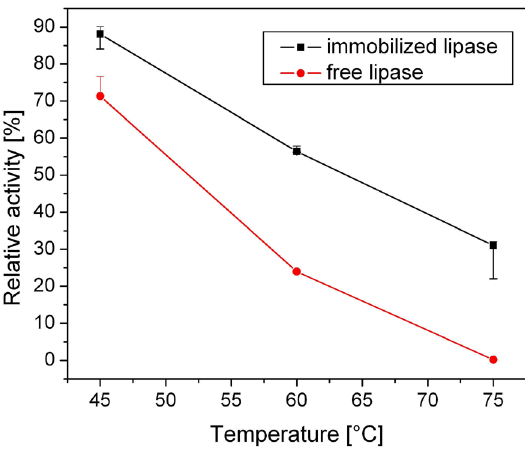
Figure 17. Effect of temperature on thermal stability of the native and immobilized